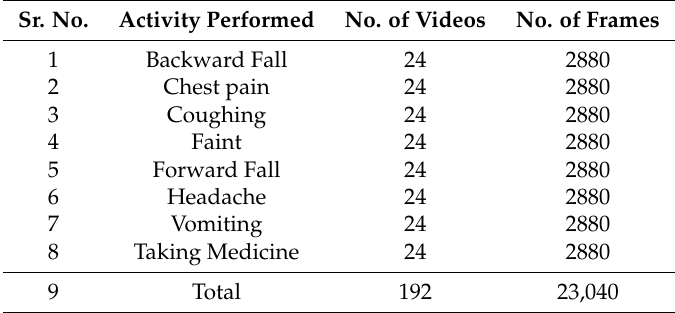
Table 3. Brief description of our dataset. It contains information about the activities performed and about videos counts. Sr. No. Activity Performed No. of Videos No. of